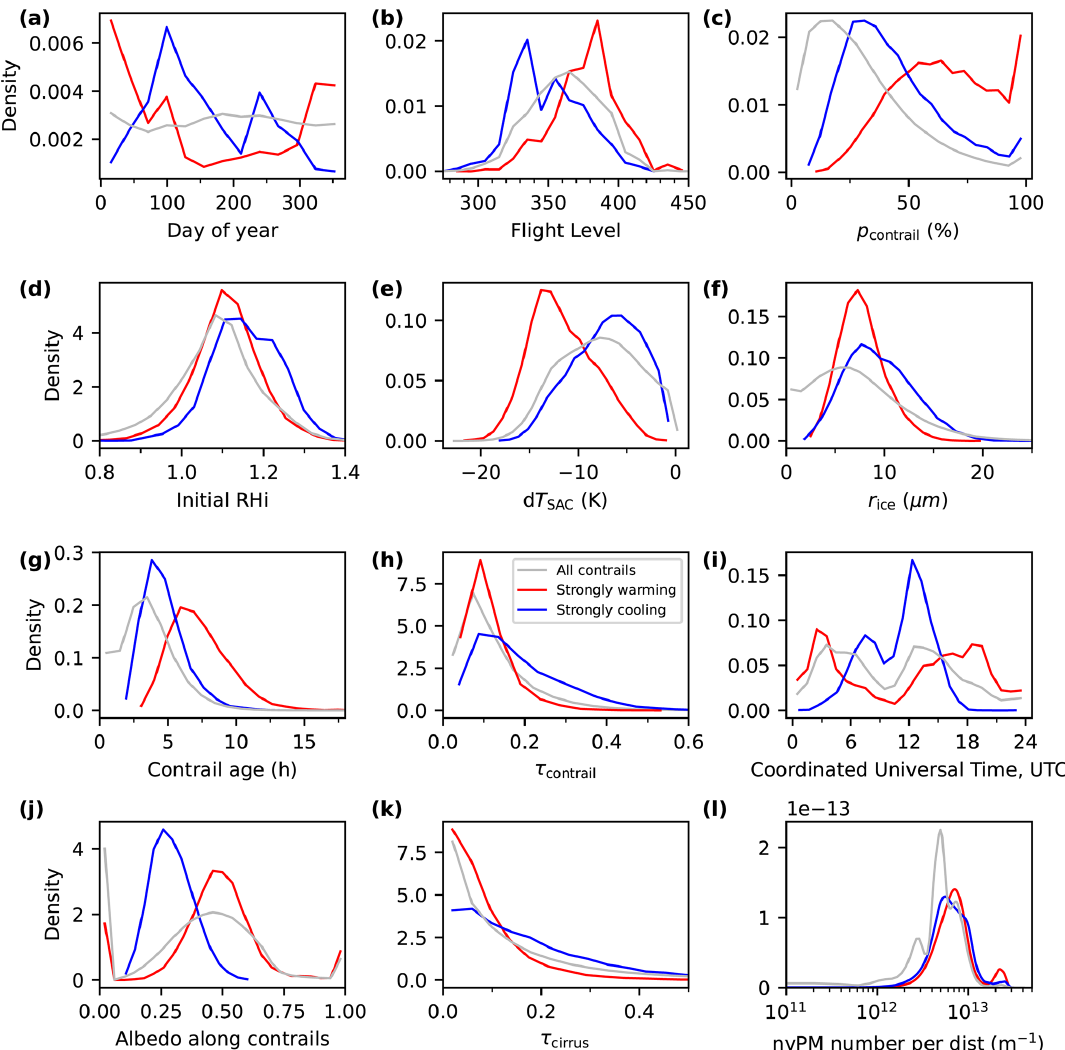
Figure 4. Probability density functions of the aircraft, meteorology and contrail properties for all contrail-forming flights (grey lines), flights with strongly warming contrails (red lines, EF contrail > 99th percentile) and flights with strongly cooling contrails (blue lines, EF contrail < 1st percentile). The “time of day” variable in panel (i) represents the time when the flight is at its midpoint between the first and final recorded